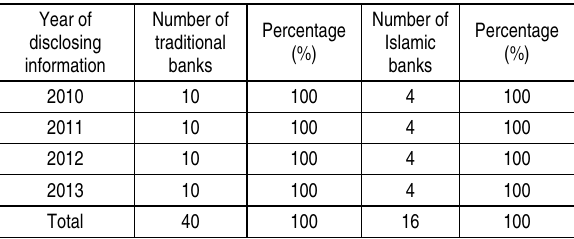
Table 3. CSR disclosures of traditional banks